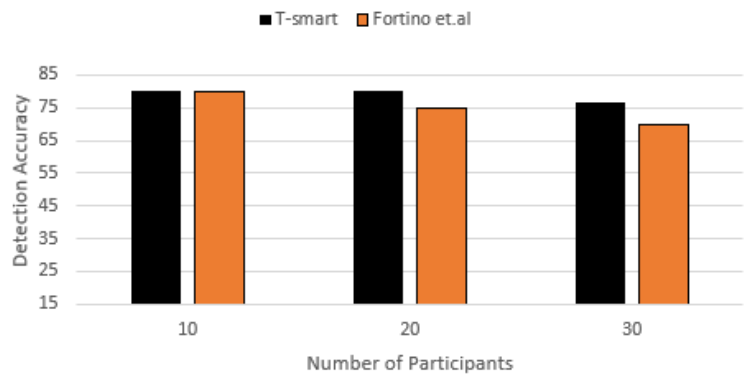
Figure 6. Accuracy with 10–30 participants.